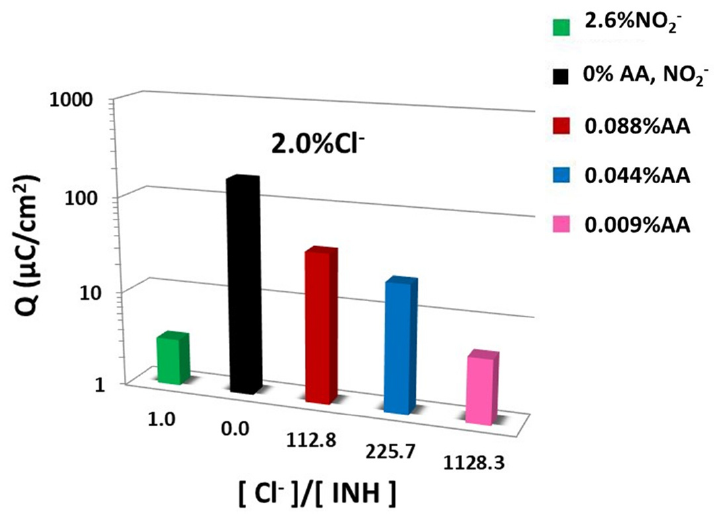
Figure 3. Electric charge vs. molar chloride/inhibitor concentration.